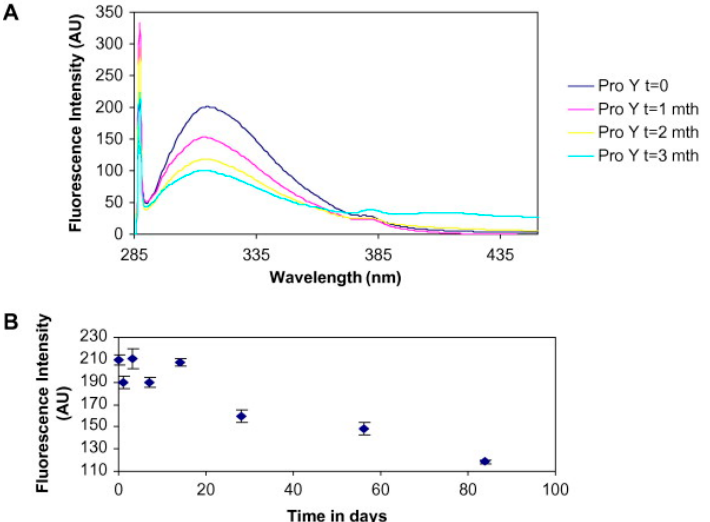
Figure 9. Solid-state (ss) fluorescence study of temperature stress effect on lyophilized protein stability. Subfigure ( A ) presents the fluorescence spectra at various time points during incubation at 60 °C. The decrease in intensity can be clearly observed. Further, the subfigure ( B ) presents the absolute fluorescence intensity versus time Reproduced with permission from [85], Elsevier, 2008.